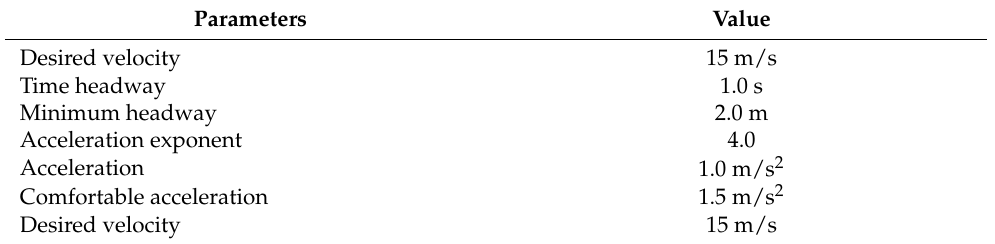
Table 1. The typical parameters for the IDM algorithm at a non-signalized intersection. Parameters Value Desired velocity 15 m/s Time headway 1.0 s Minimum headway 2.0 m Acceleration exponent 4.0 Acceleration 1.0 m/s 2 Comfortable acceleration 1.5 m/s 2 Desired velocity 15